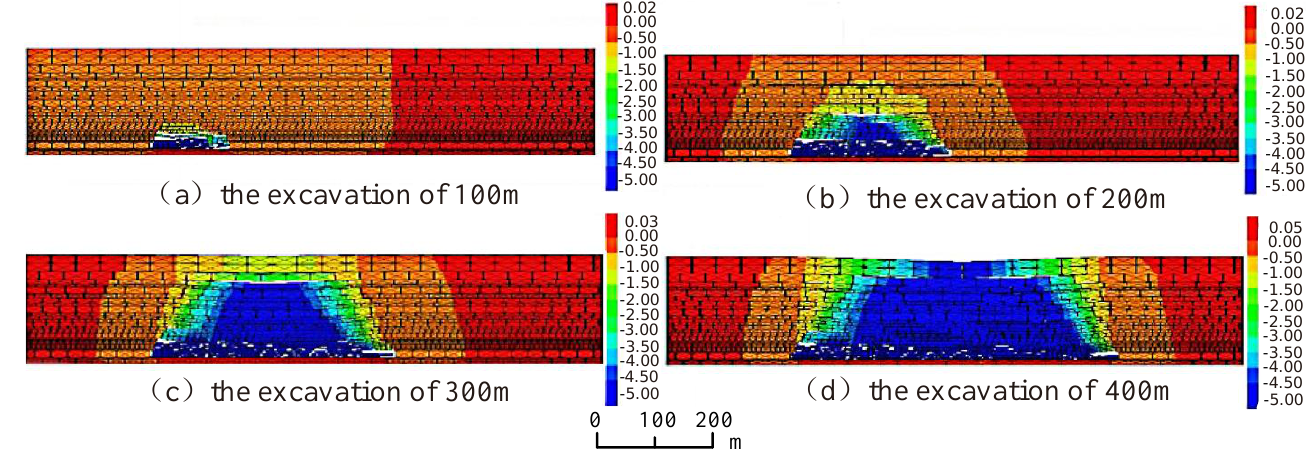
Figure 6. ( a – d ) describes the dynamic distribution of the vertical displacement in overlying strata during different excavation periods of 100 m, 200 m, 300 m and 400 m.